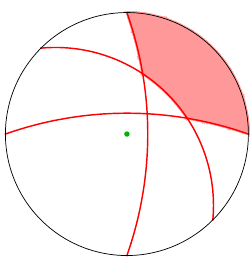
Figure 10. A cross-section of an intersecting annulus brane configuration involving three branes. The red shaded region is taken to be the bulk region dual to the BCFT. There are two corners, both of which involve a brane not directly attached to the conformal